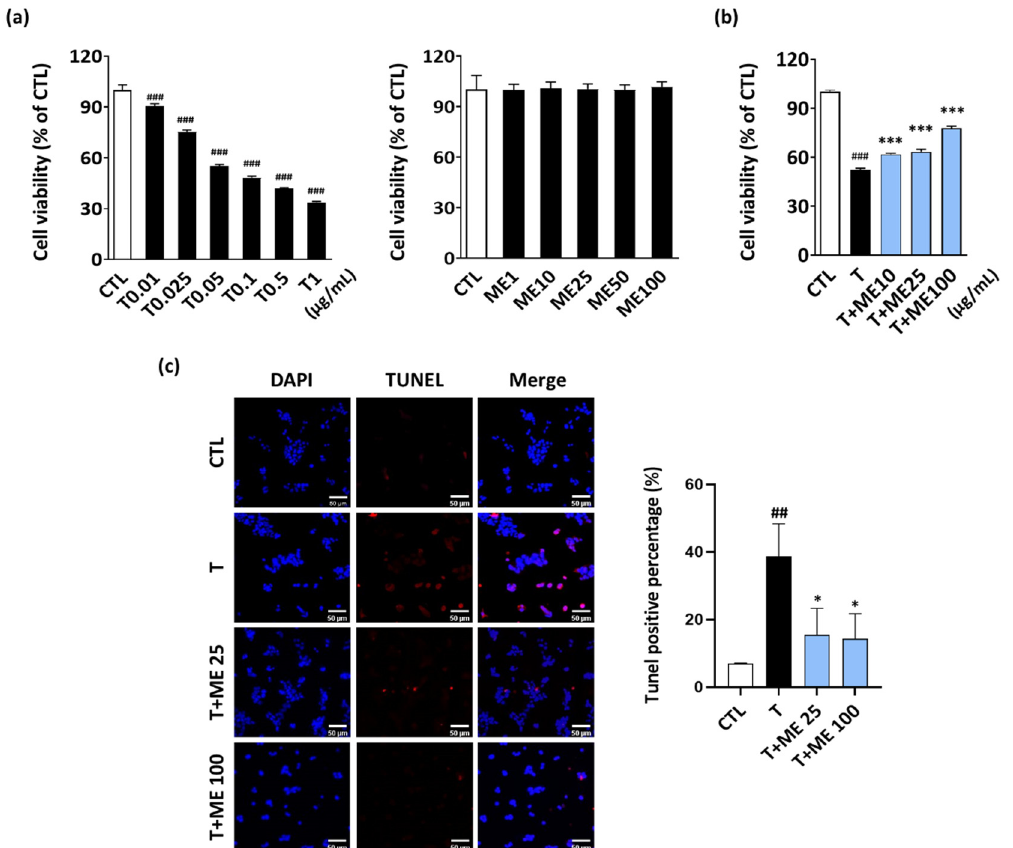
Figure 2. Effect of ME on the viability of tunicamycin-treated NIT-1 pancreatic β -cells. ( a ) NIT-1 pancreatic β -cells (2 × 10 4 cells/well) were treated with tunicamycin or ME alone for 24 h. Cell viability was determined using the MTT assay. ( b ) NIT-1 pancreatic β -cells were co-treated with ME (10, 25, or 100 μ g/mL) for 24 h in the absence or presence of tunicamycin (0.05 μ g/mL). ( c ) In situ apoptosis was evaluated using DAPI and TUNEL staining assays. Results are the mean ± SD of three separate experiments performed in triplicate. ## p < 0.01, ### p < 0.001 versus CTL (vehicle-treated cells); * p < 0.05, *** p < 0.001 versus tunicamycin-treated cells. T: tunicamycin; ME: Mori Ramulus ethanol extract.